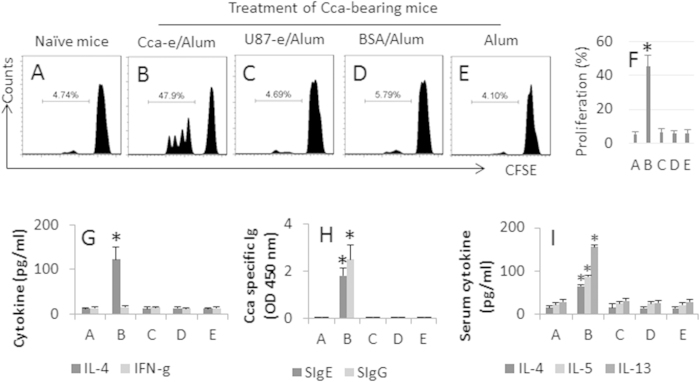
Cca-specific Th2 response in mice.The treatment of Cca-bearing BALB/c mice was denoted above the flow cytometry histograms. Teff cells (labeled with CFSE) and DCs (T cell:DC = 5:1) were isolated from the spleens and cultured in the presence of Cca-e (10 μg/ml) for 3 days. A–E, the histograms indicate the proliferation of the Teff cells. F, the bars indicate the summarized data of A–E. G–I, assessed by ELISA, the bars indicate the levels of cytokines in the culture supernatant of A–E (G), the serum specific IgE and IgG of the mouse groups A–E (H), and the serum Th2 cytokine levels of the mouse groups A–E (I). The data of F–I are presented as mean ± SD. *, p < 0.01, compared with group A. Each group consisted of 10 mice. The data are representatives of 10 independent experiments.